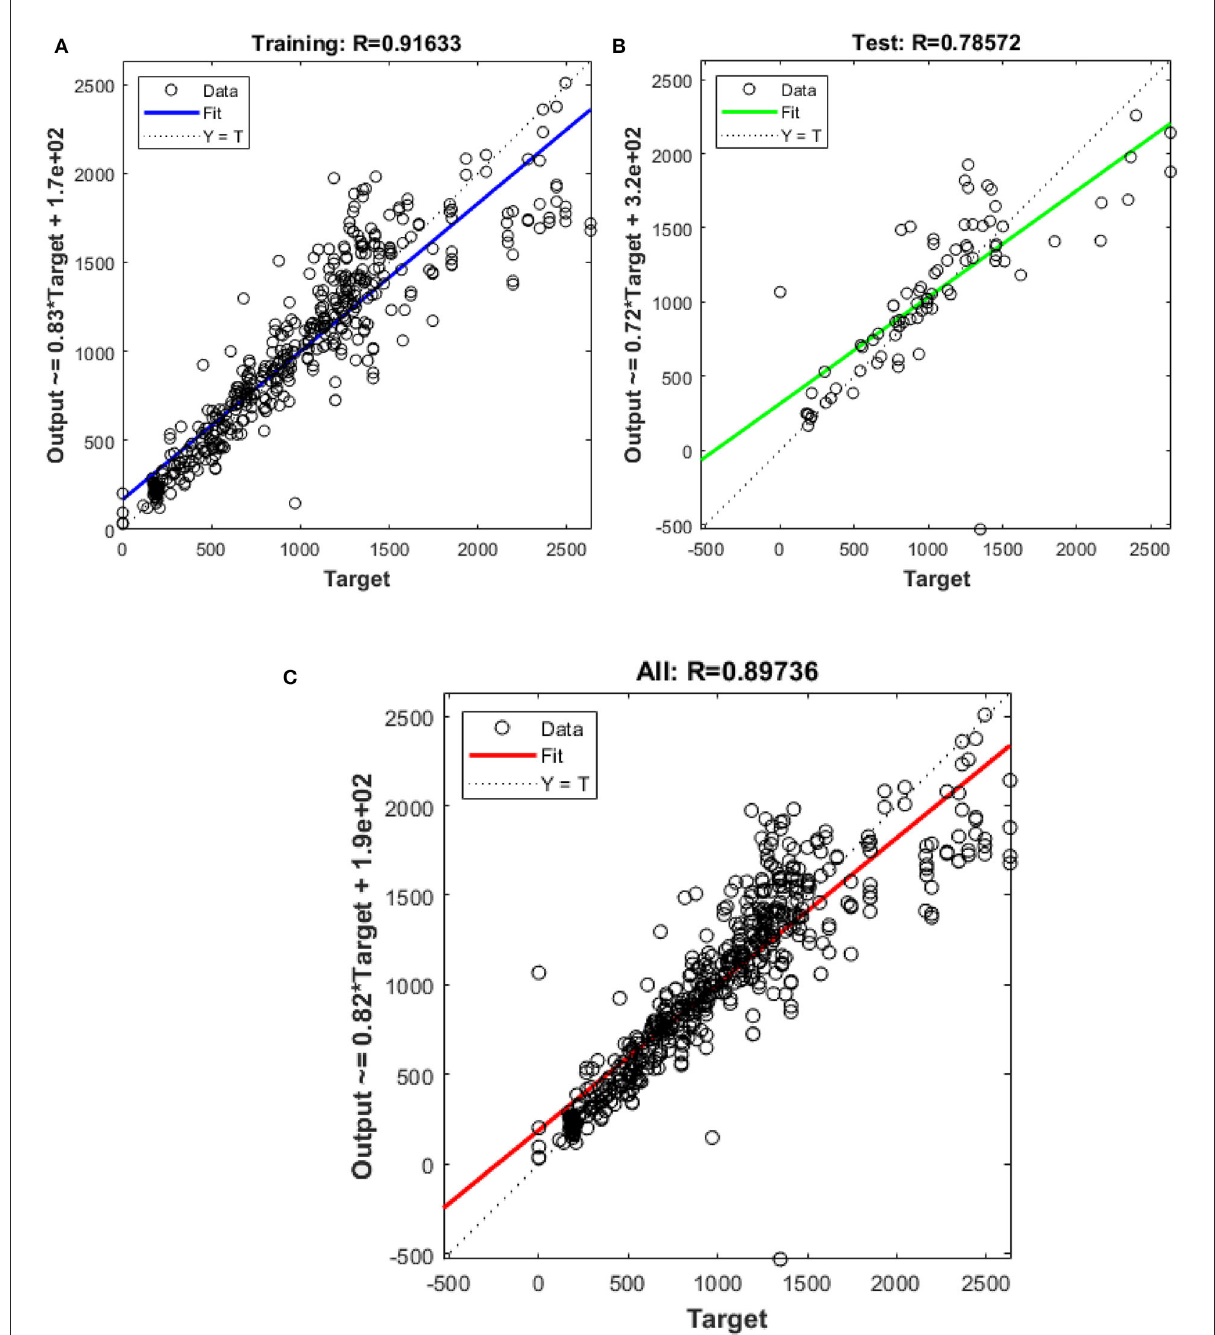
FIGURE4 Outputs of (A) training (B) test (C) all data sets by Bayesian algorithm as a function of actual (target) DLP.